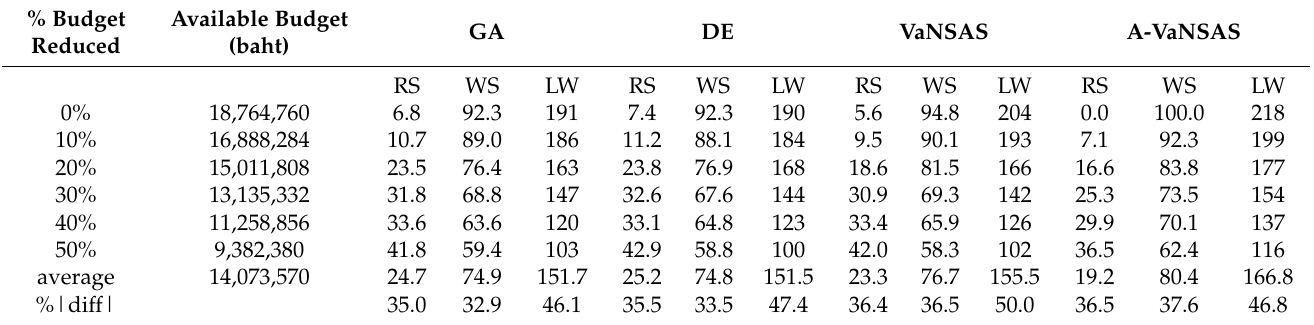
Table 5. Total risk and LW of the proposed method with different budget limitations.